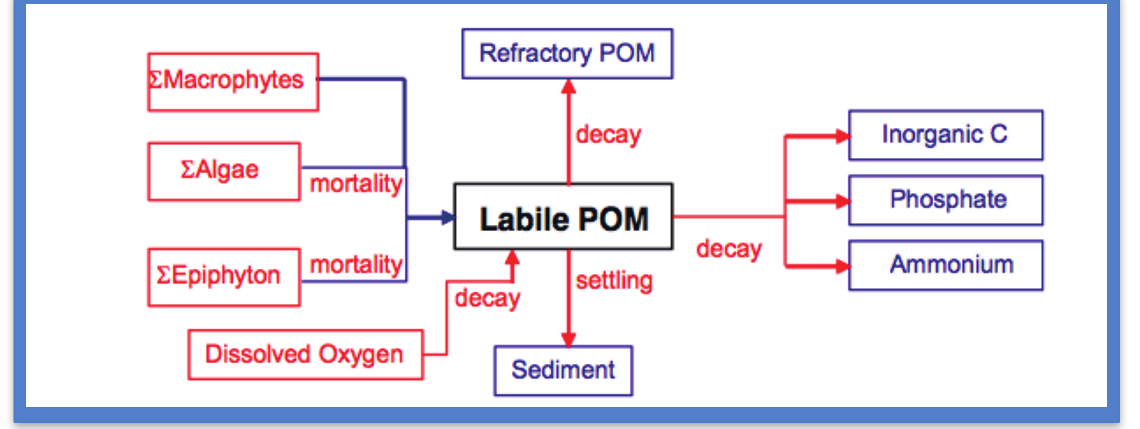
Figure 9. CE-QUAL-W2 mass balance processes internal to a volume for labile particulate organic matter